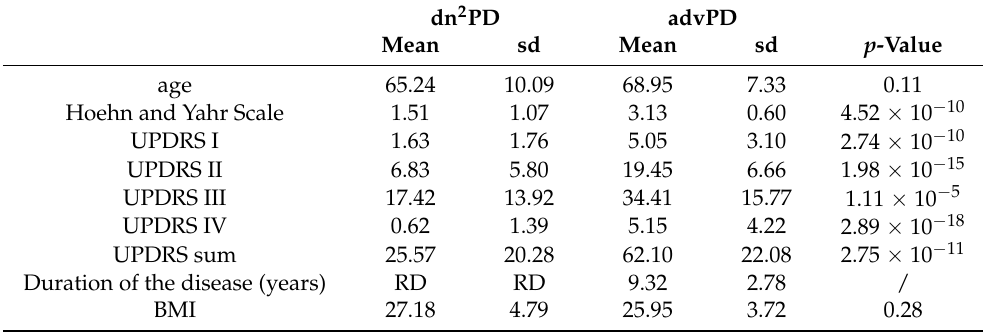
Table 2. Characteristics of PD patients and severity scores. Total UPDRS score includes various items contributing to four subscales: (I) mentation, behavior, and mood; (II) activities of daily living; (III) motor symptoms; and (IV) complications of